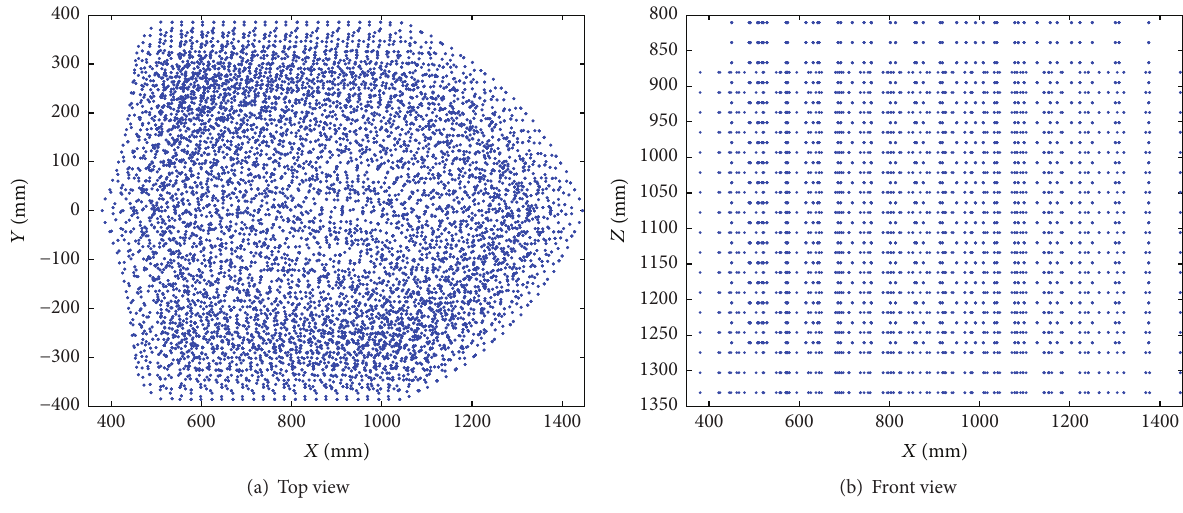
Figure 6: Reachable